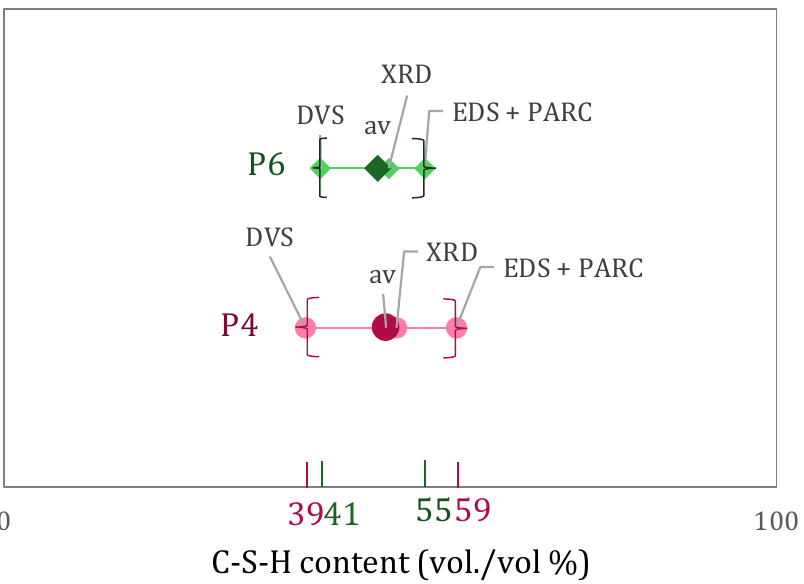
Figure 4. C-S-H content as determined by XRD coupled with Rietveld + PONKCS, by EDS coupled with PARC and by DVS data.